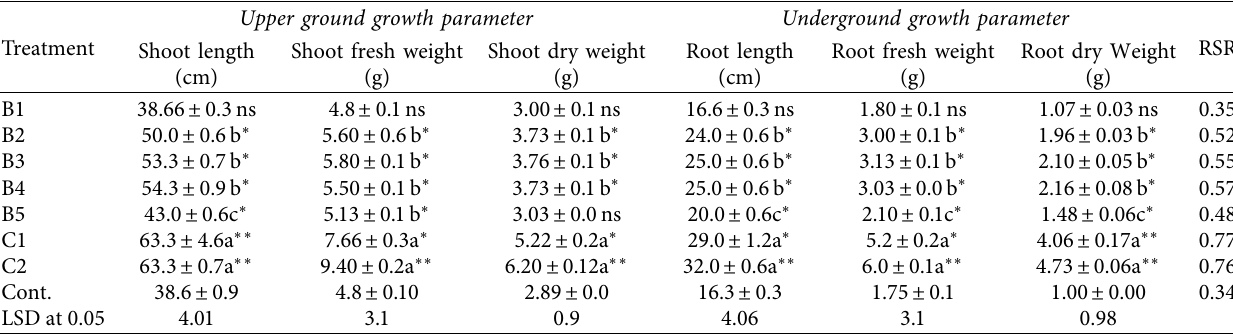
Table 6: The effect of Bacillus and Cyanobacteria on the growth of Rice Cv. Getachew seedlings. Treatment